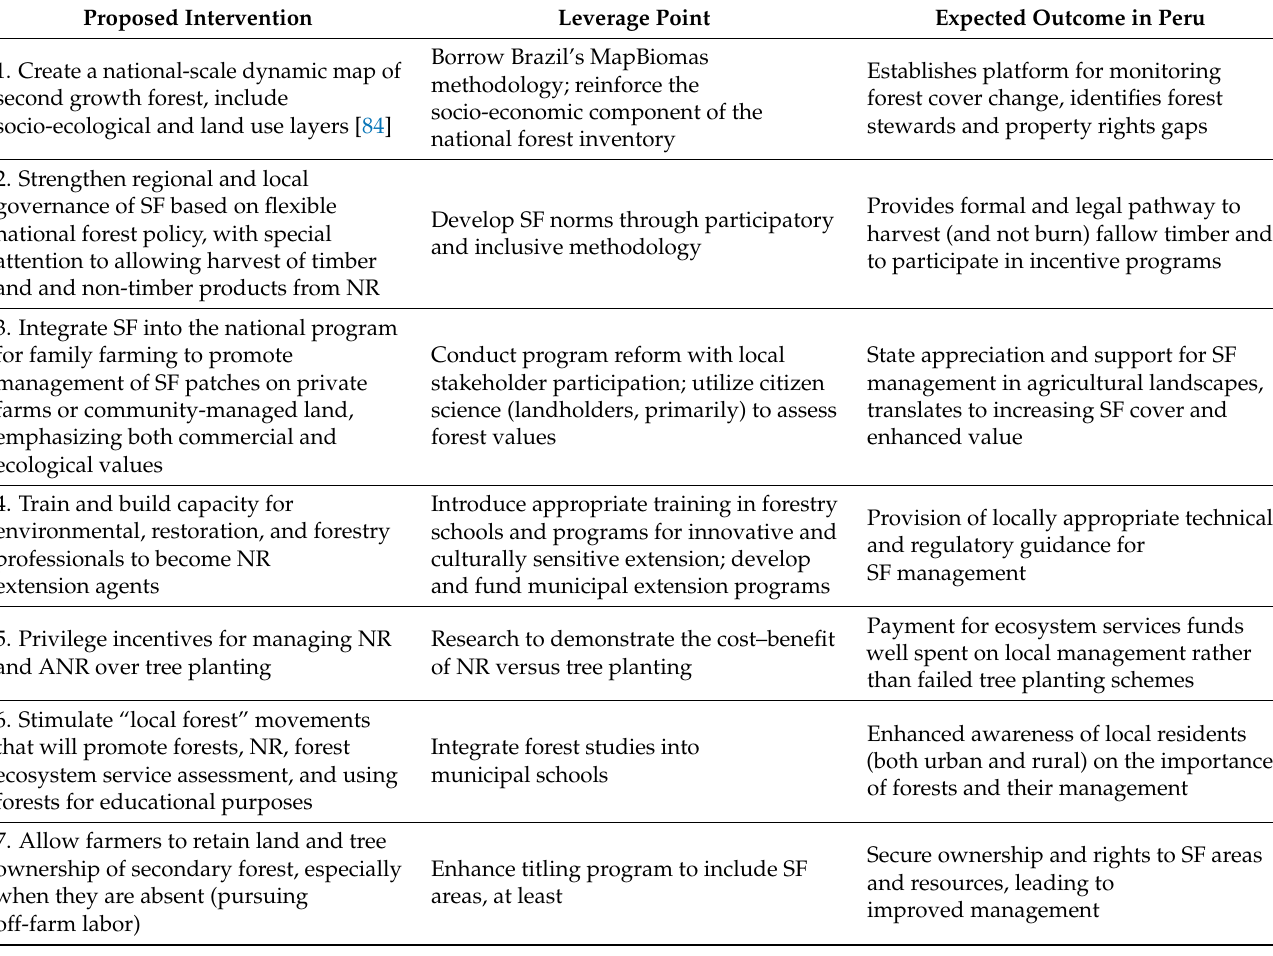
Table 3. Suggested interventions at the national and sub-national levels to provide positive support for secondary forest governance (adapted from Chazdon, et al. [12]). (SF, secondary forest; NR, natural forest regeneration; ANR, assisted natural